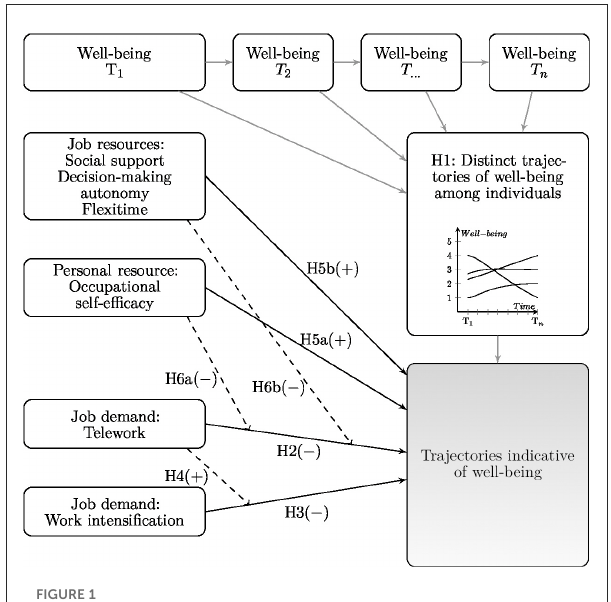
FIGURE1 Proposed model. Dashed lines indicate